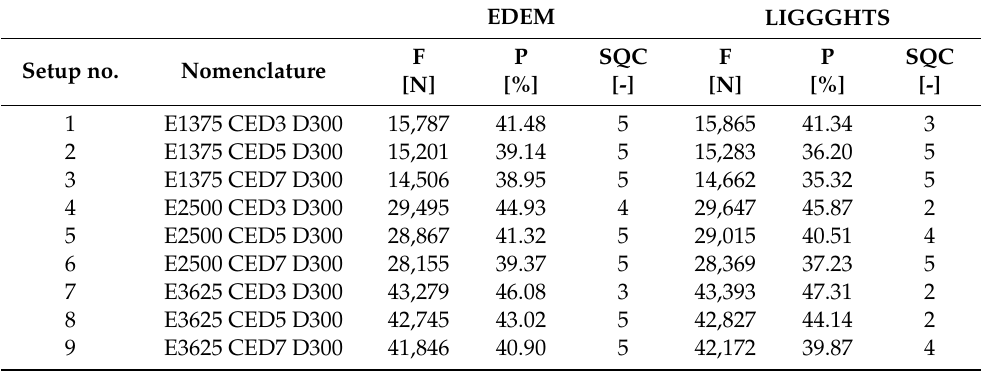
Table 7. Results obtained in the simulations used for the calibration of the DEM models. EDEM